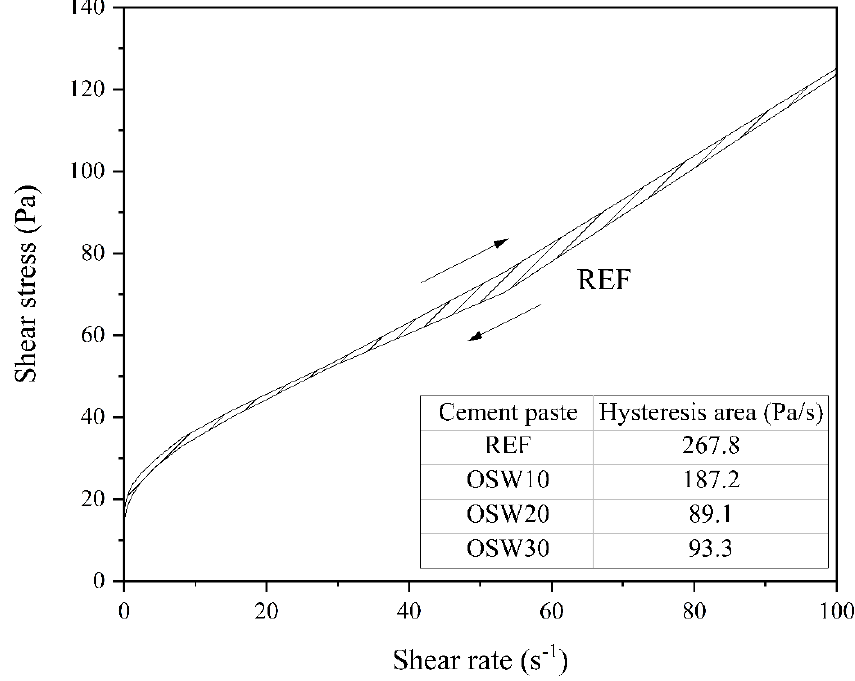
Figure 8. Example of hysteresis area determination of cement pastes evaluated.